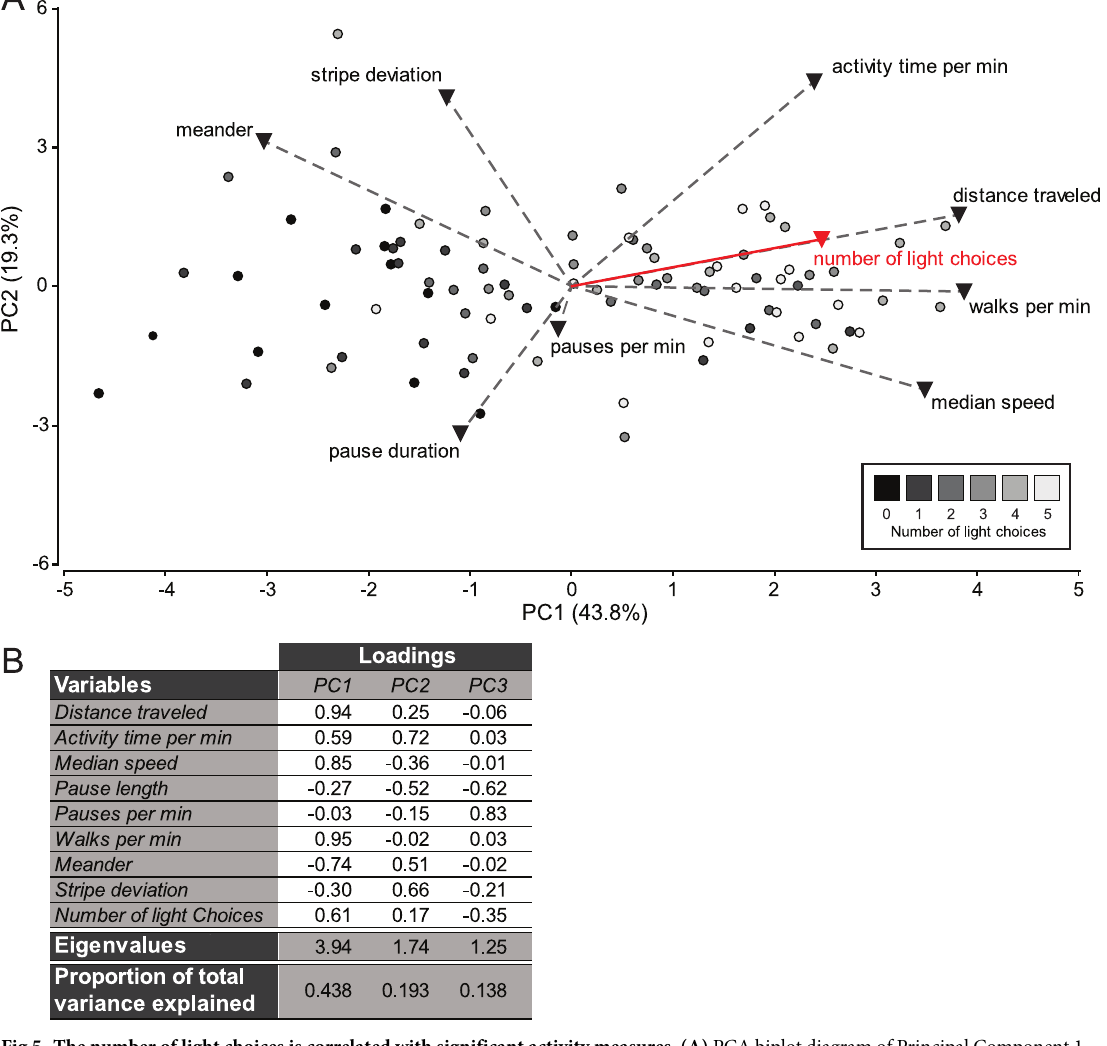
Fig 5. The number of light choices is correlated with significant activity measures. (A) PCA biplot diagram of Principal Component 1 (PC1) vs. Principal Component 2 (PC2). Samples are displayed as dots of different colors depending on their number of light choices. Variables are displayed as vectors: activity measures, dashed lines with black triangles; number of light choices, red line and triangle. The length of a vector is proportional to the variance of the corresponding variable. The angle between the vectors approximates the correlation between the variables they represent. The numbers in brackets represent the amount of variability in the original variables explained by the principal component. (B) Loadings, Eigenvalues and the Proportion of Variance explained for each of the first three Principal Components. The loadings of the PCs are the correlations of each variable on each PC. Therefore, original variables with high loadings (either positive or negative) are more closely related to the patterns revealed by the PC.